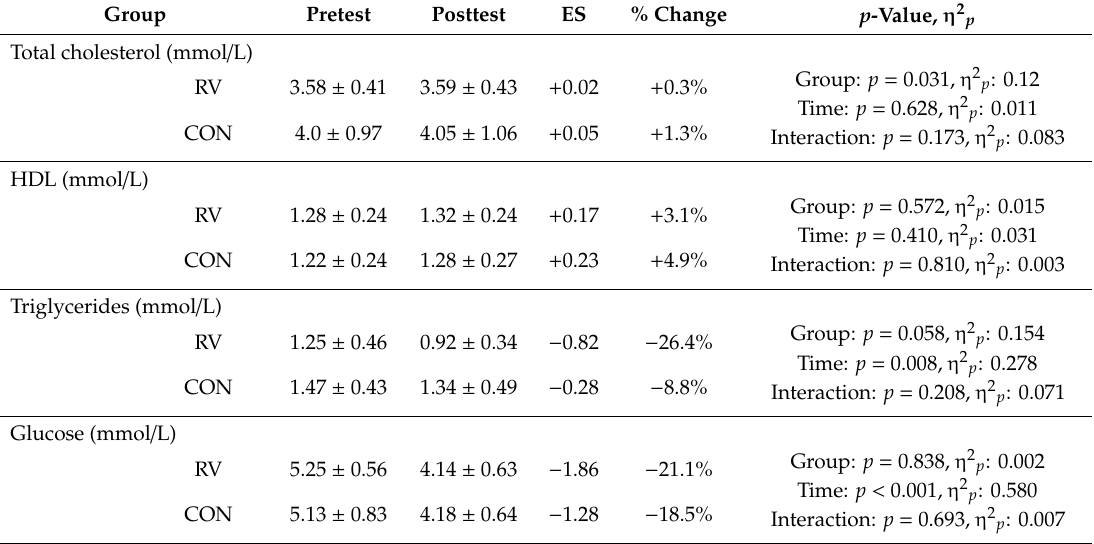
Table 1. Biochemical